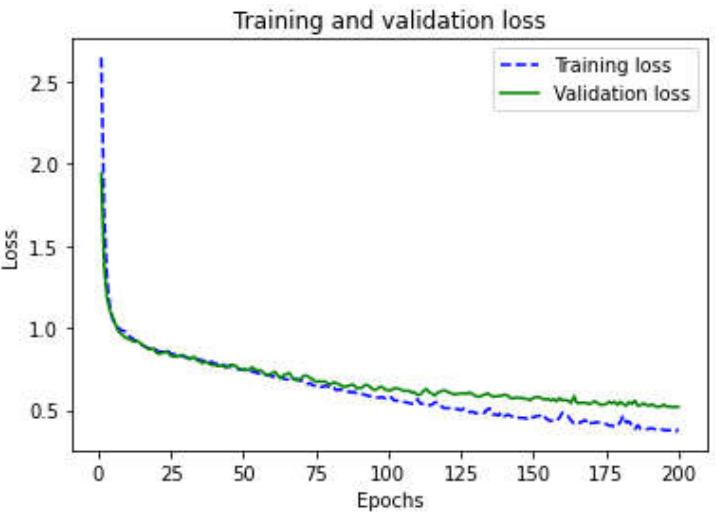
Figure 5. Training and Validation Loss Rate.